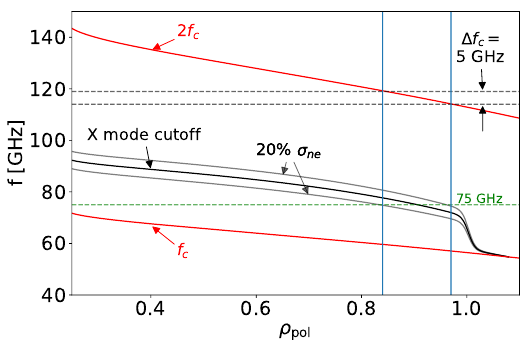
Figure 5. The first two cyclotron harmonics and the X-mode cut- o ff frequency profile. A 20% error in the density profile leads to a significant uncertainty in the radial position of the reflectome- ter. For this case, a CECE channel comb with a bandwidth of 5GHz should be su ffi cient to capture the coherence between re- flectometer and